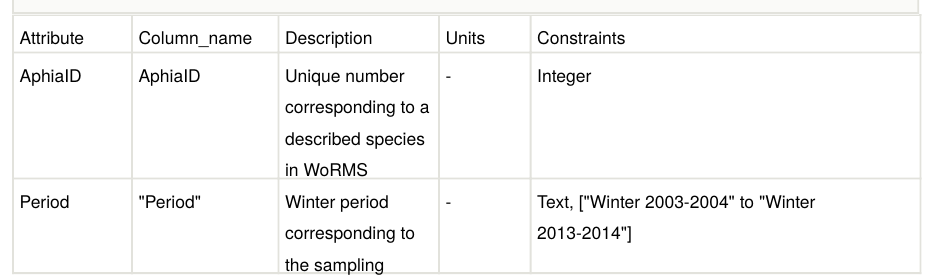
Table of attributes, with associated column names, description, units and constraints in the benthos